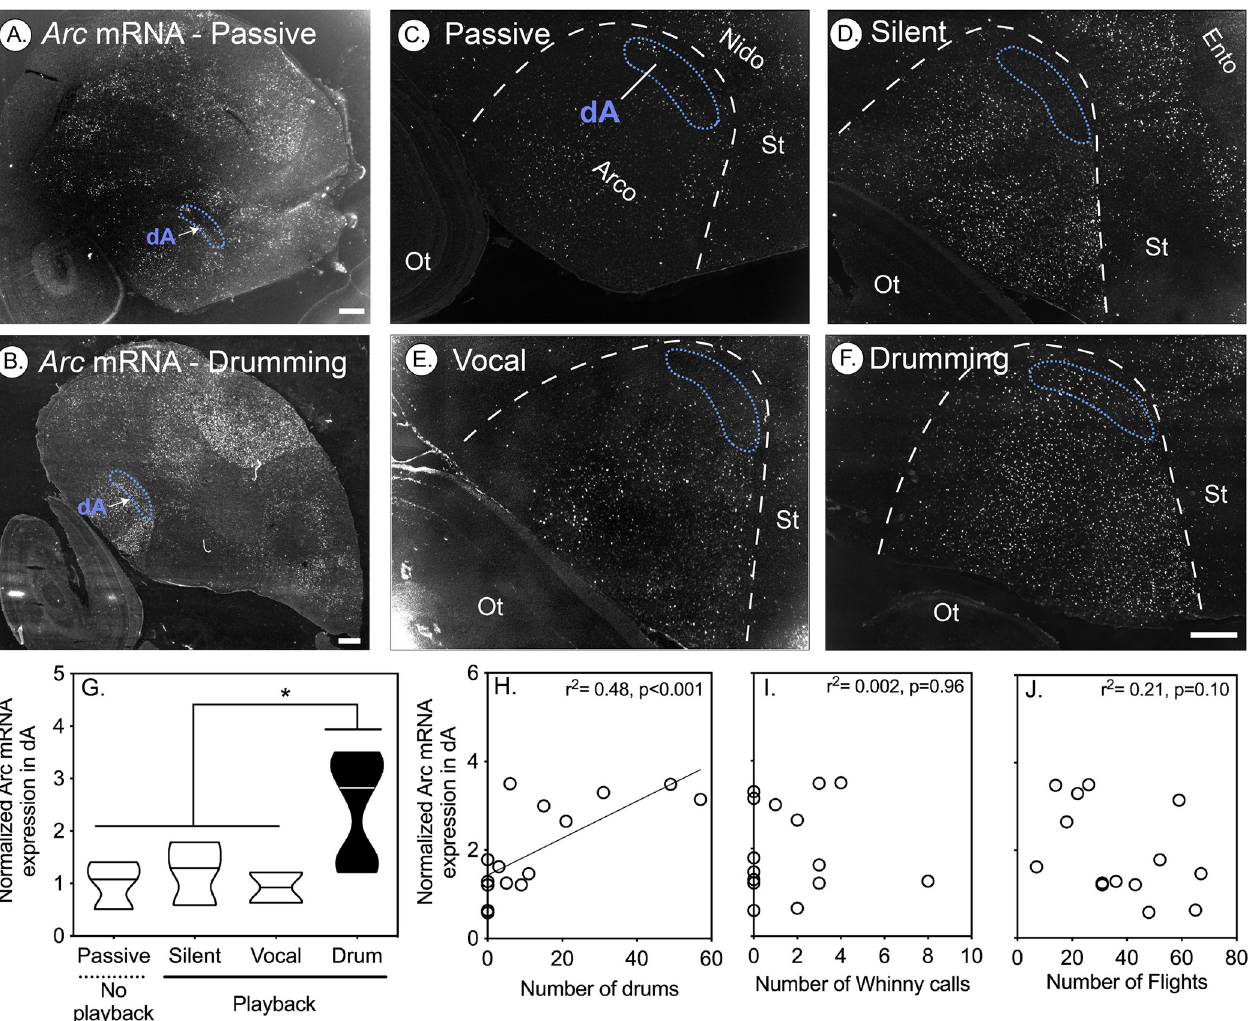
Fig 6. Activity induced Arc expression in the dorsal nucleus of the arcopallium (dA) of male downy woodpeckers positively correlates with drumming behavior. (A-B) Representative low-magnification in situ hybridization microscope images of Arc mRNA expression (white), with fast red as a counterstain (grey) in downy woodpeckers that were either passively caught (A) or (B) after drumming during a simulated territorial encounter (STI). (C-F) Representative high-magnification examples of Arc mRNA image in (C) passively caught birds ( n = 3) or birds that listened to STI playback (see Materials and methods) but either (D) did not produce vocalizations or drums (silent, n = 3), (E) produced only vocalizations and no drums ( n = 2), or (F) produced drums ( n = 10). White dashed lines in high-magnification images indicate boundaries between the arcopallium and nidopallium, whereas blue dashed lines indicate specialized PV regions identified in downy woodpeckers. PV -rich dA area on each section was determined from PV mRNA on an adjacent slide. (G) Violin plots (horizontal line denotes median) illustrating in Arc gene expression in the dA of downy woodpeckers caught after producing different behaviors. IEG expression significantly differed in the dA ( F = 4.74, p = 0.02), with drumming birds having significantly greater Arc mRNA compared to all other groups (all relevant 3 , 14 comparisons: p < 0.05). (H) Arc mRNA expression in dA was positively correlated with the number of drums ( p < 0.001). We did not find this relationship with Arc expression and the total number of aggressive vocalizations (I) or flights (J). Significant correlations have solid lines ( p < 0.05). Data for G-J can be found in S2 Data.